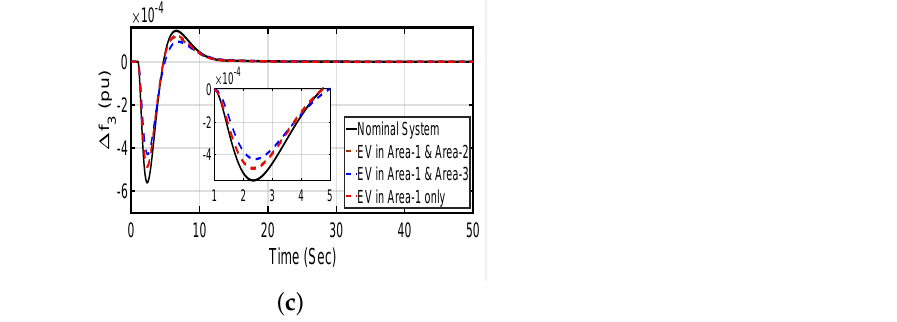
Figure 15. Response comparison when EVs are connected Area 1 only, Area 1 and Area 2, Area 1 and Area 3 of the HES. ( a ) ∆ f 1 ; ( b ) ∆ f 2 ; ( c ) ∆ f 3 .